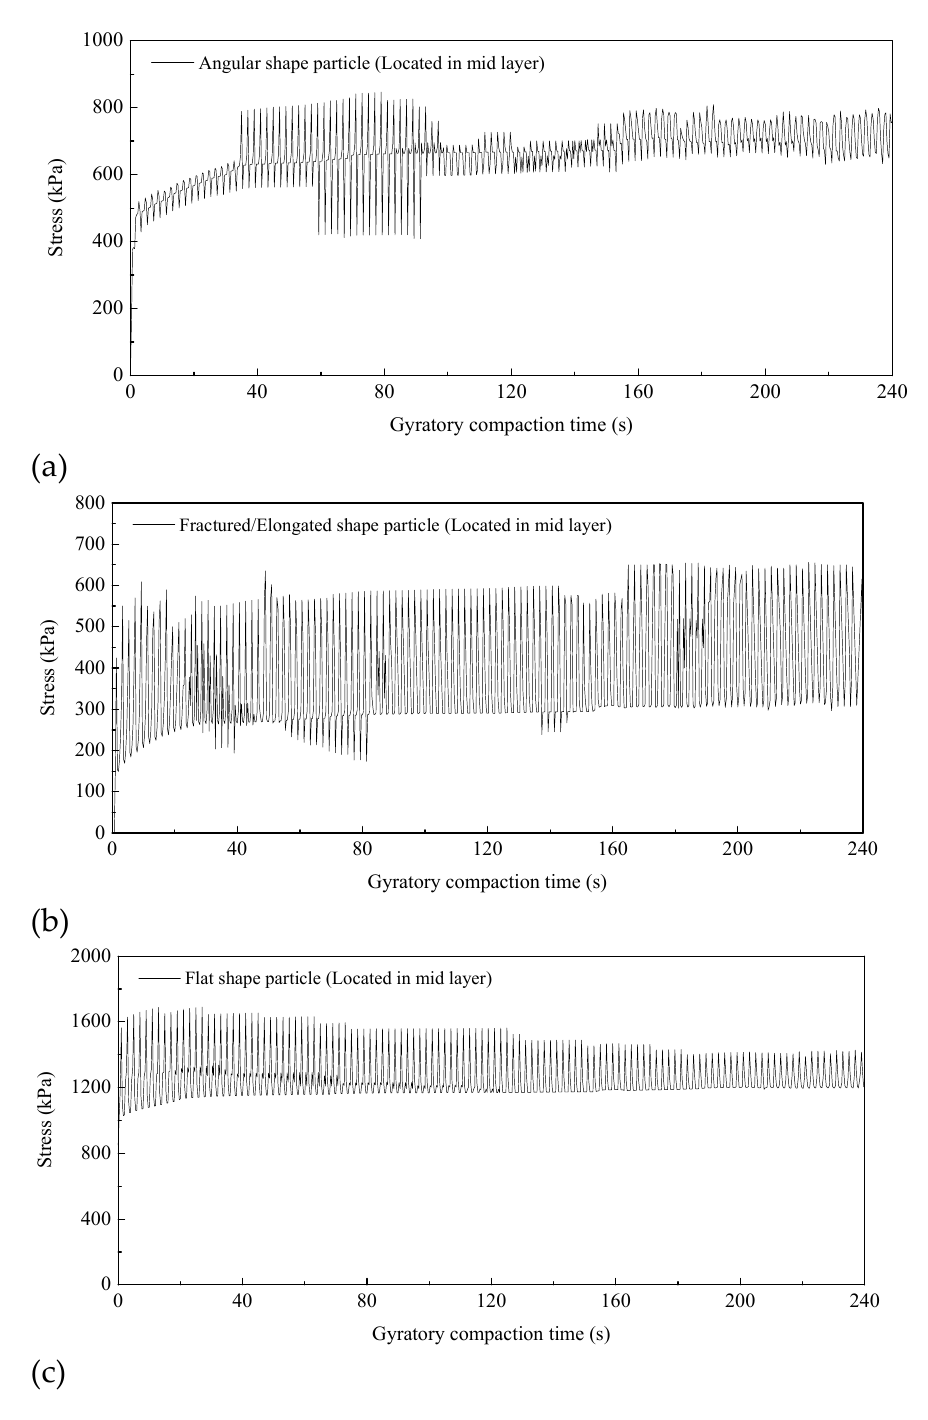
Figure 10. Particles’ contact stress (with angular, fractured/elongated and flat shapes) located in the mid-layer, tracked by DEM.